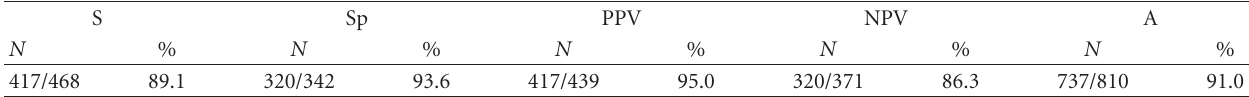
Table 1: Evaluation of the sensitivity (S), specificity (Sp), positive predictive value (PPV), negative predictive value (NPV), and accuracy (A) for the total group in the study of the presence or absence of simulated lesions.